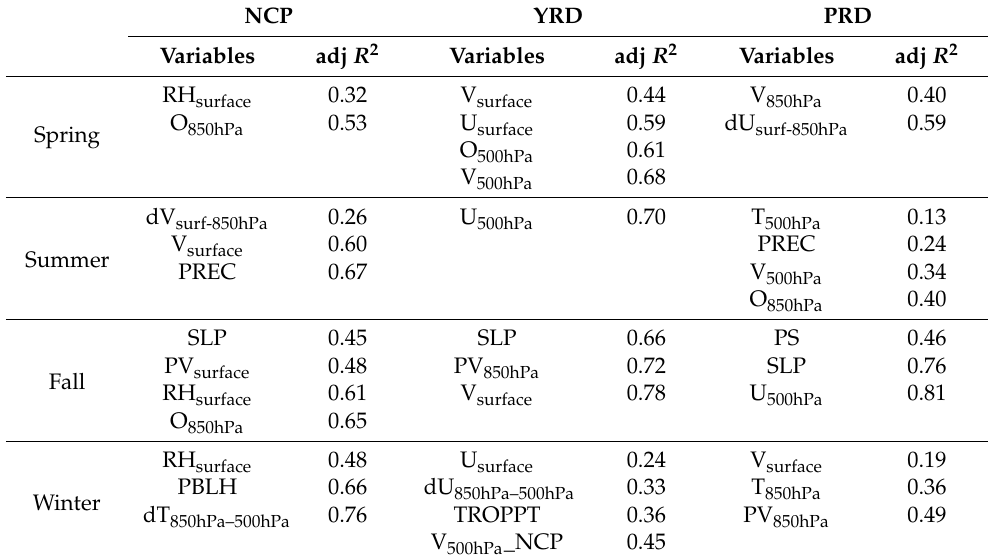
Table 3. Meteorological elements that explain inter-annual variations of surface PM 2.5 in NCP, YRD, and PRD between 2006 and 2017 in different seasons.